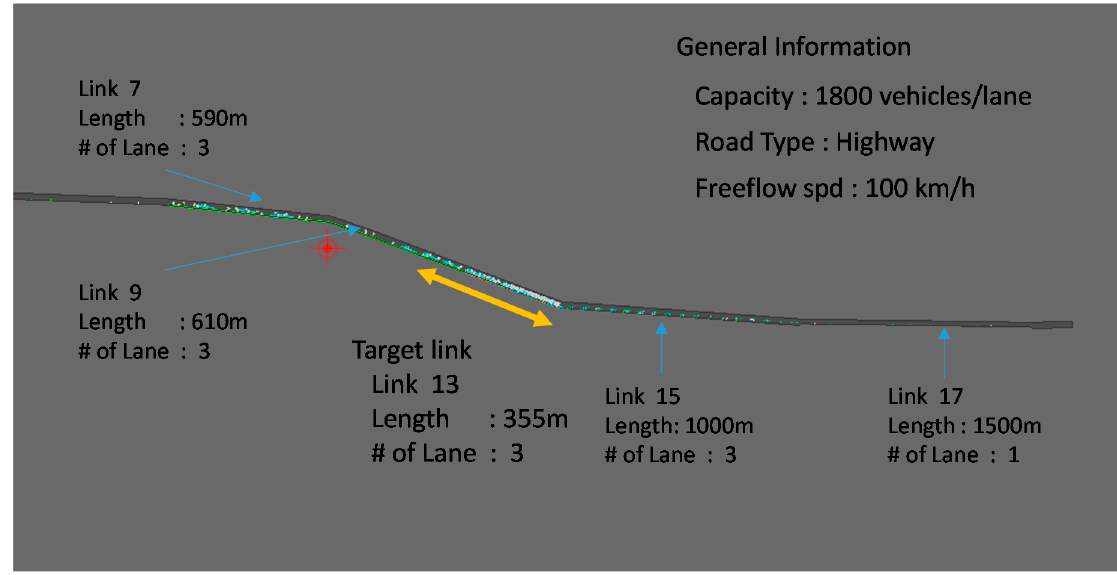
Figure 6. The overview of the hypothetical network.